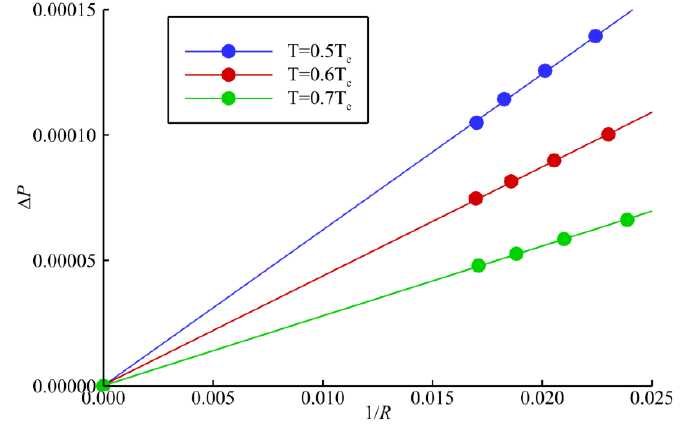
Figure 1. Laplace’s law validation.